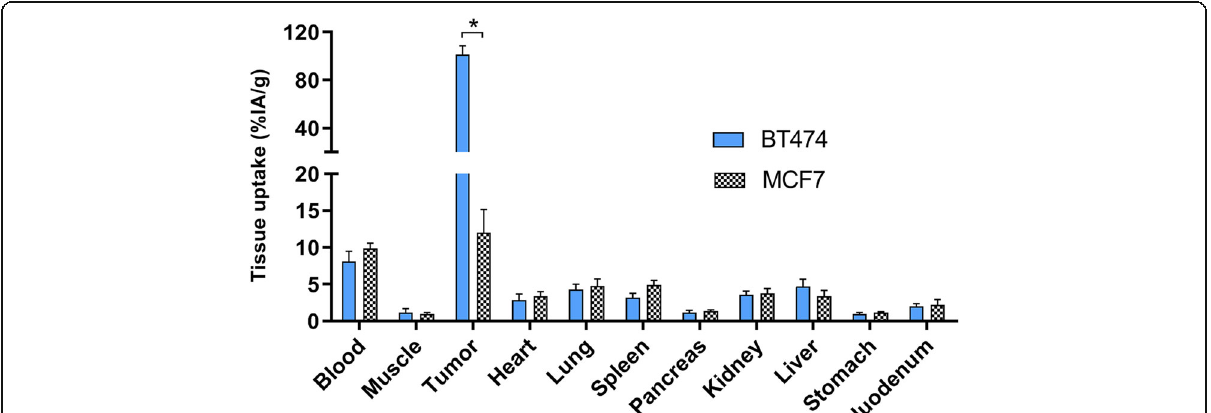
Fig. 3 Biodistribution of 30 μ g [ 111 In]In-DTPA-trastuzumab-IRDye800CW 48 h after injection in orthotopic MCF7 tumor-bearing mice (black and white blocks), compared with uptake in BT474 tumors (blue). Tumor uptake in MCF7 tumors was significantly lower in comparison with uptake in